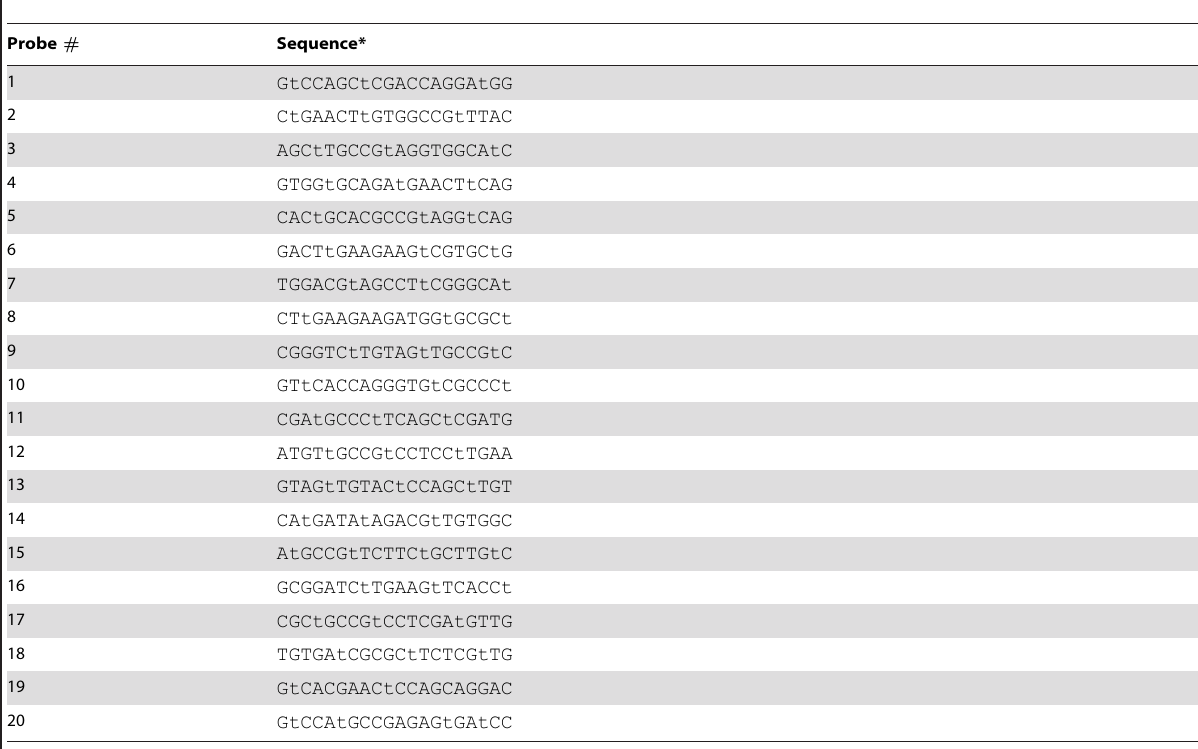
Table 1. Sequences of amino-labeled probe set for single molecule RNA FISH.